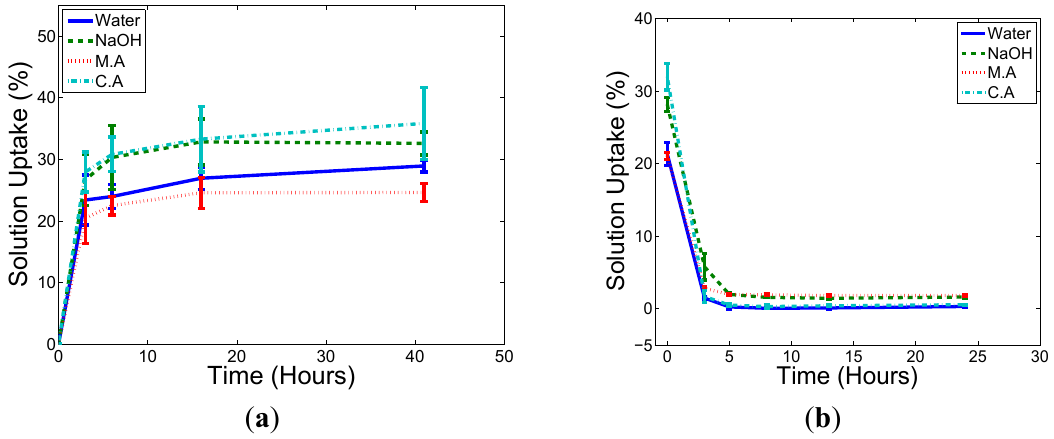
Figure 2. The rate of solution uptake ( a ); and subsequent moisture egress from saturation ( b ) for the NFC rectangular